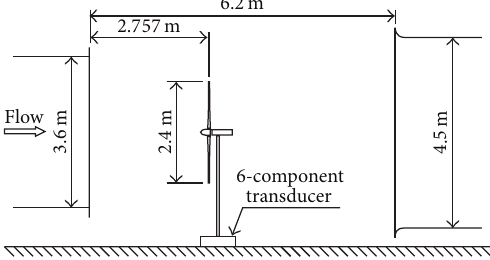
Figure 1: Experimental apparatus from Mie University.